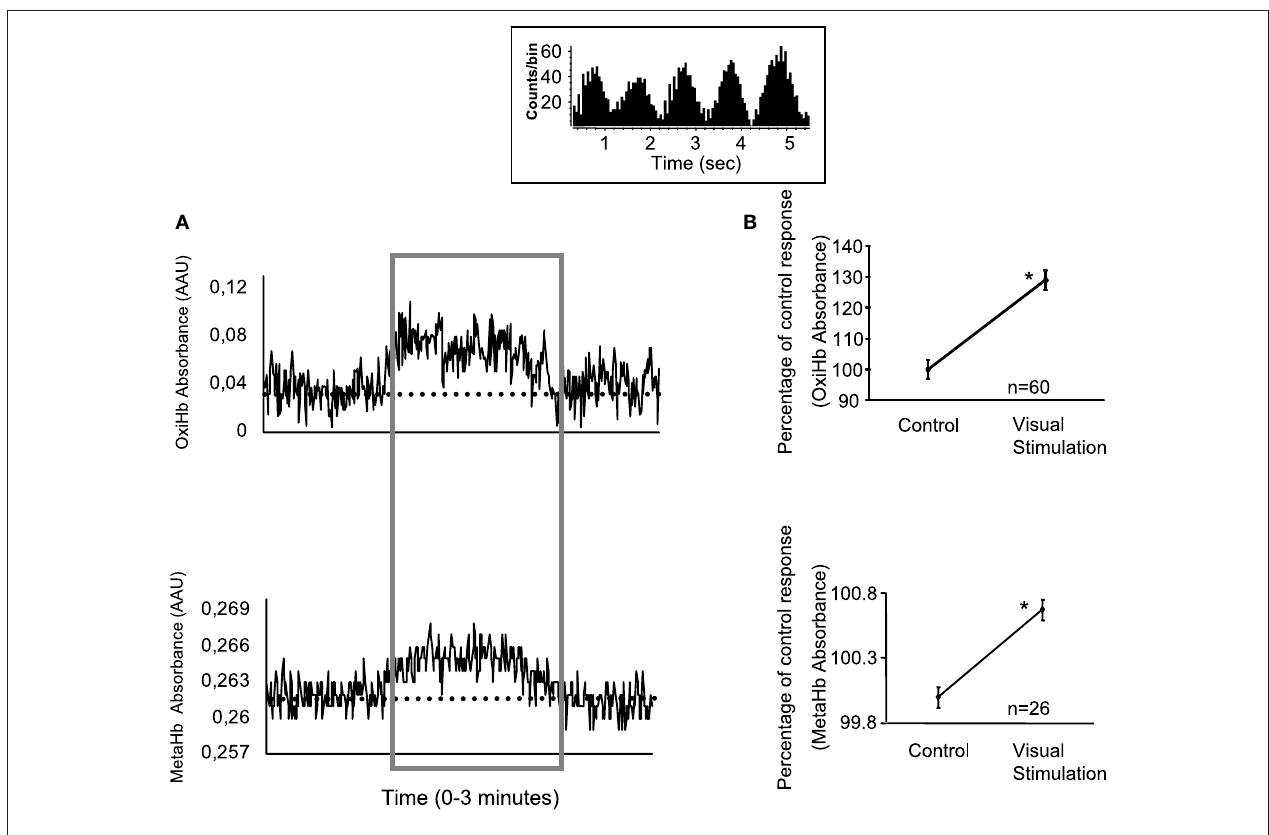
FIGURE 1 | Modulation of OxyHb and MetHb levels by visual stimulation. (A) Typical example of the effects obtained upon metabolic markers with the presentation of a visual stimulus. Each record shows a period of spontaneous activity, prior to a period of visual stimulation (area within the box) which produces an increase of OxyHb and MetHb levels (recorded simultaneously).